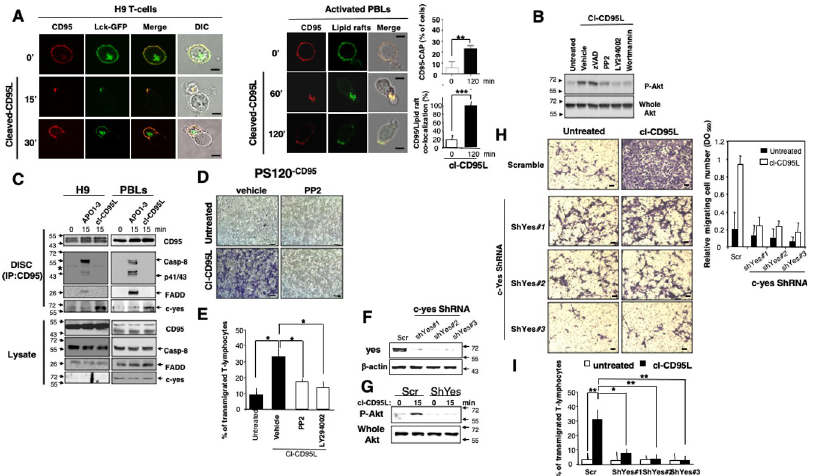
Fig 5. The src kinase c-yes orchestrates the cl-CD95L-mediated PI3K/Akt signaling pathway and cell migration. (A) Left panels : The leukemic cell line H9 was transiently transfected with Lck-GFP. 24 h after transfection, living cells were treated or untreated for the indicated times in the presence of cl-CD95L (100 ng/ml). 0 min (0’) condition corresponds to cells analyzed prior to the addition of 100 ng/mL of cl-CD95L. CD95 was stained using a mouse anti- CD95 mAb and a goat Alexa555-coupled anti-mouse IgG mAb. Right panels : Activated PBLs were incubated for the indicated times with 100 ng/ml of cl-CD95L, and then cells were fixed. Lipid rafts were stained using Alexa488-cholera toxin B subunit and CD95 was followed as previously mentioned. Images were acquired with a confocal microscope with a 63 × objective. 0 min (0’) condition corresponds to cells analyzed prior to the addition of 100 ng/mL of cl- CD95L. Cell morphology was followed using phase contrast microscopy (Bars = 7.5 mm). The percentage of T-cells displaying a CD95 cluster was assessed (300 cells counted for each condition). Among the activated T-lymphocytes showing CD95 cluster, the amount of CD95-CAP co-localized with lipid rafts was assessed. (B) H9 T-cells were pre- incubated for 30 min with DMSO (vehicle), 10 mM of PP2, 5 mM of LY294002 (LY), 2.5 mM of wortmannin (Wort), or 40 mM of zVAD-fmk (zV) and then treated for 15 min with 100 ng/ml of cl-CD95L. Untreated condition corresponds to cells incubated with supernatant of pcDNA3.1(+)-transfected HEK cells. Cells were lyzed and Akt phosphorylation (S 473 ) and whole Akt were assessed by immunoblots. (C) The H9 T-cell line ( left panels ) and activated PBLs ( right panels ) were incubated for indicated times with 100 ng/ml of cl-CD95L or APO1-3. APO1-3 is an agonistic anti-CD95 mAb incubated for 15 min with indicated cells to activate CD95 and trigger DISC formation. Then, cells were lyzed and CD95 was immunoprecipitated. The 0 min condition corresponds to unstimulated cells directly lyzed to next immunoprecipitate CD95. APO1-3 also serves for the immunoprecipitation step of CD95 (see Materials and Methods). The immune complex was resolved in a 10% SDS-PAGE and indicated immunoblots were performed. Total lysates were depicted to confirm that the same amount of protein was present for each immunoprecipitation. The black stars represent heavy chains of Ig. (D) Boyden chamber assays were performed as described in Materials and Methods. PS120 CD95 (All PS120 cells have been reconstituted with wild type NHE1 (see Materials and Methods) were pre-incubated with or without a non-cytotoxic and non-cytostatic concentration of PP2 (10 mM) or DMSO (vehicle) for 30 min and then treated (cl-CD95L) or untreated (Untreated condition corresponds to cells incubated with supernatant of pcDNA3.1(+)-transfected HEK cells) for 24 h with 100 ng/ml of cl-CD95L. Data are representative of three independently performed experiments. The vehicle conditions in the presence or absence of cl-CD95L also serve in S9B Fig to decipher the effect of zVAD-fmk. (E) Activated PBLs were pre-incubated with 10 mM of the src inhibitor PP2, 5 mM of the PI3K inhibitor LY294002 (LY) or DMSO (vehicle) and then incubated in the presence of cl-CD95L (100 ng/ml) for 24 h. Untreated cells correspond to activated PBLs incubated for 24h with supernatant of pcDNA3.1 (+)-transfected HEK cells. Then, endothelial transmigration of PBLs was assessed as described in Materials and Methods. (F) The silencing effect of the c-yes-targeting shRNAmir-pGIPZ vectors was analyzed by immunoblot in lentiviral-transduced PS120 CD95 cells. 72 h after transduction, cells were lysed and 100 mg of lysate was loaded per line. β -actin serves as loading control. (G) The T-cell line H9 was transduced with scramble (scr) or c-yes (shYes#3)- targeting shRNAmir-containing lentivirus. 72 h after transduction, living cells were harvested and green cells were sorted by flow cytometry using FACSAria. Cells were immediately stimulated with cl-CD95L (100 ng/ml) (15 min) or left untreated (0 min), and the amounts of Akt phosphorylation (S 473 ) were assessed by immunoblot. (H) Cell migration of indicated shRNAmir-transduced PS120 CD95 was assessed using the Boyden chamber assay. Left panels : 72 h after transduction, cells were treated (cl-CD95L) or untreated (supernatant of pcDNA3.1(+)-transfected HEK cells) with 100 ng/ml of cl-CD95L for 24 h. For each experiment, five pictures of the migrating cells were taken, and a representative picture was depicted (Bars = 50 mm). Right panel : To quantitatively measure cell motility, Giemsa- stained migrating cells from the lower side of the membrane were lyzed and absorbance was measured at a wavelength of 560 nm. Values represent means and SD of three independently performed experiments. (I) H9 cells were transduced as mentioned in (G), and the green cells were incubated in the presence of cl-CD95L (100 ng/ml) or supernatant of pcDNA3.1(+)-transfected HEK cells (untreated) for 24 h. Then, the endothelial transmigration of the sh-RNA-expressing T-cells was assessed as described in Materials and